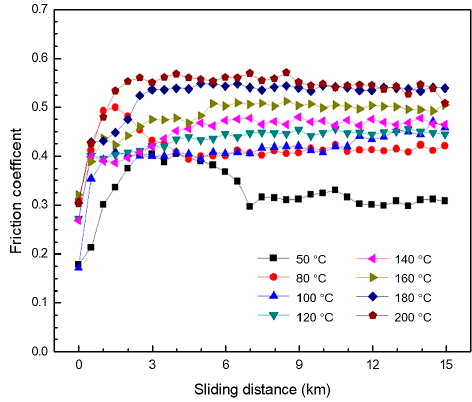
Figure 3. The representative friction coefficient versus sliding distance curves at different temperatures.